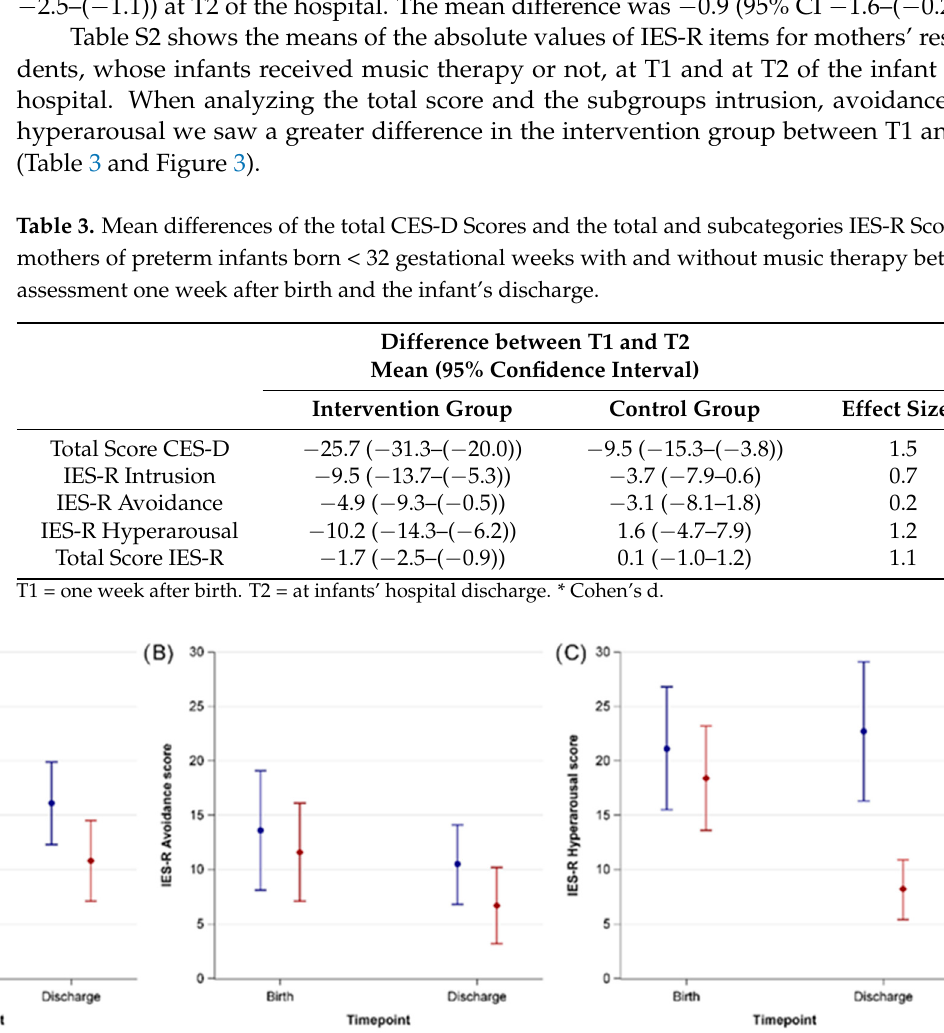
Figure 3. Absolute changes of IES-R Items of mothers of preterm infants with music therapy (red diamonds) and without music therapy (blue circles) one week after birth and at the infants’ dis- charge from hospital. ( A ) Intrusion. ( B ) Avoidance. ( C ) Hyperarousal. Error bars represent 95% con- fidence intervals.